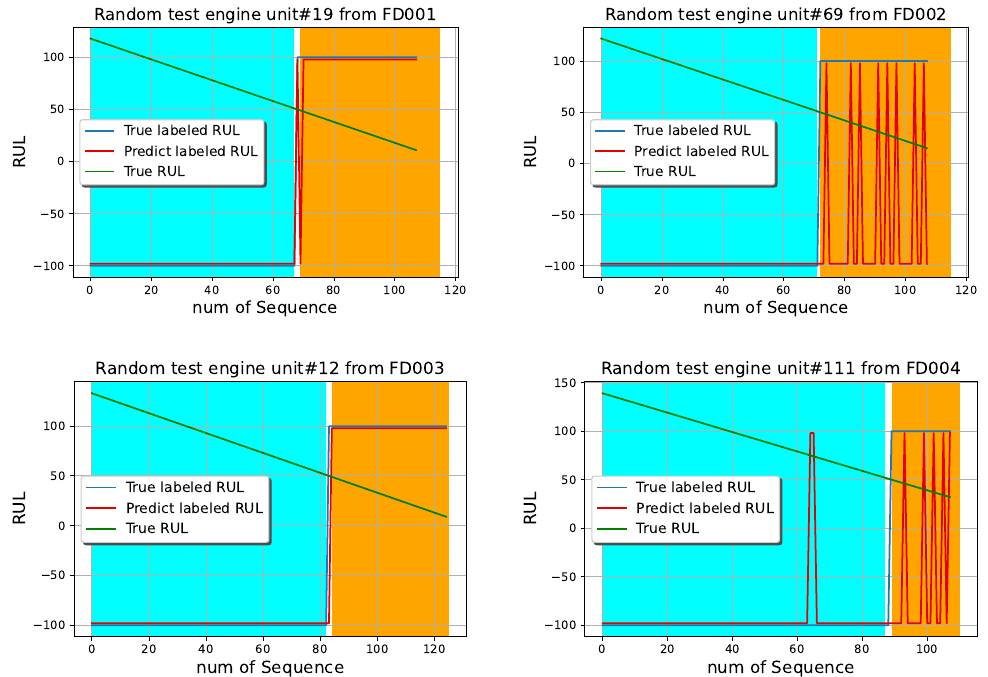
Figure 10. Four example of labeled RUL predictions for the testing engine based on the synchronous FedSVM